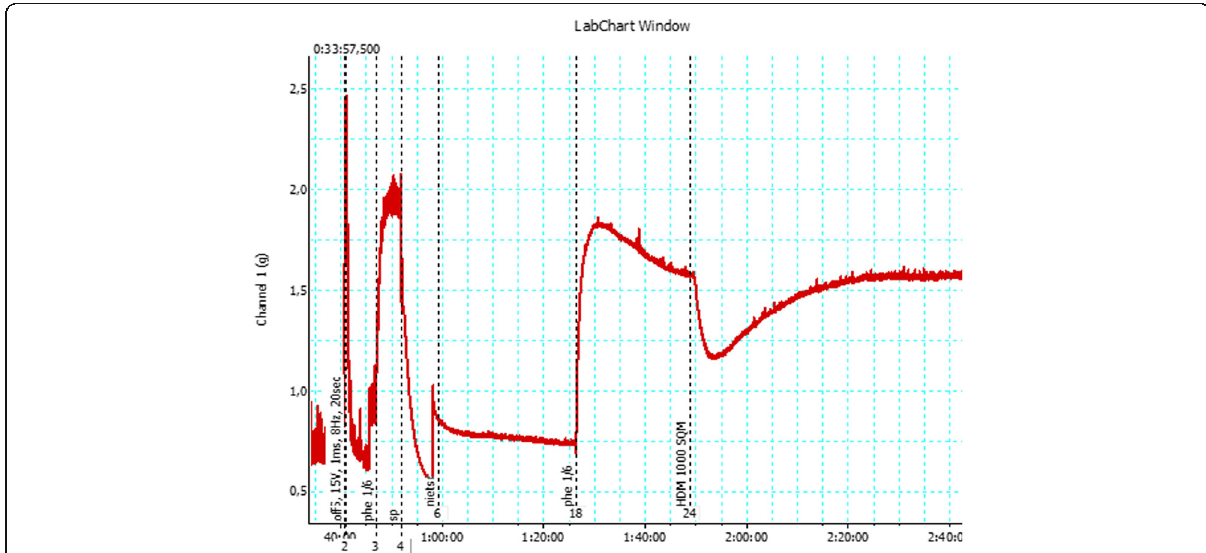
Fig. 2 Positive controls: normal responses to EFS (8 Hz) and phenylephrine (10 − 6 M) followed by response to HDM (1000 SQM) on